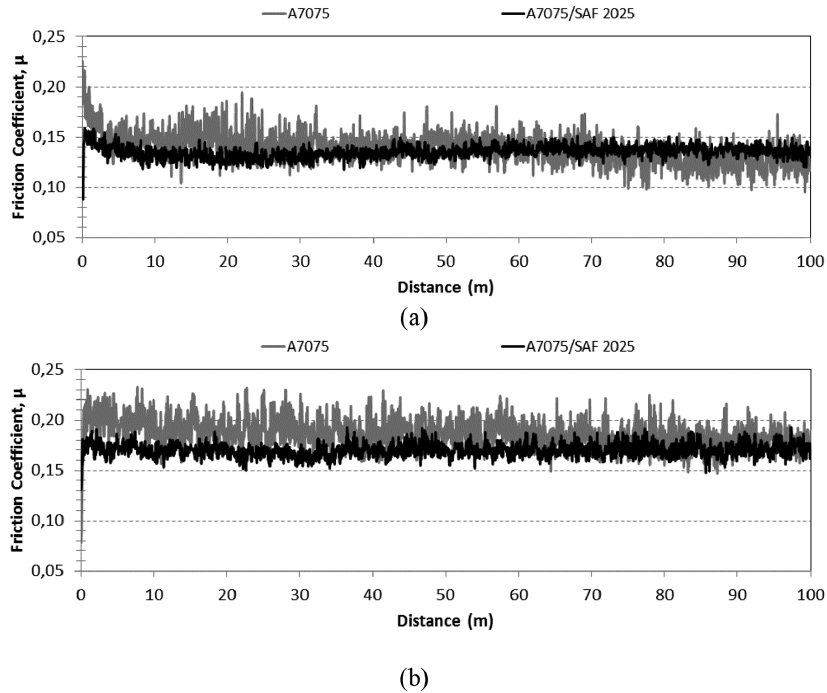
Figure 4: The diagram showing the variation of friction coefficients as a function of distance with the interaction of 100Cr6 (a) and ZrO 2 counterpart (b).